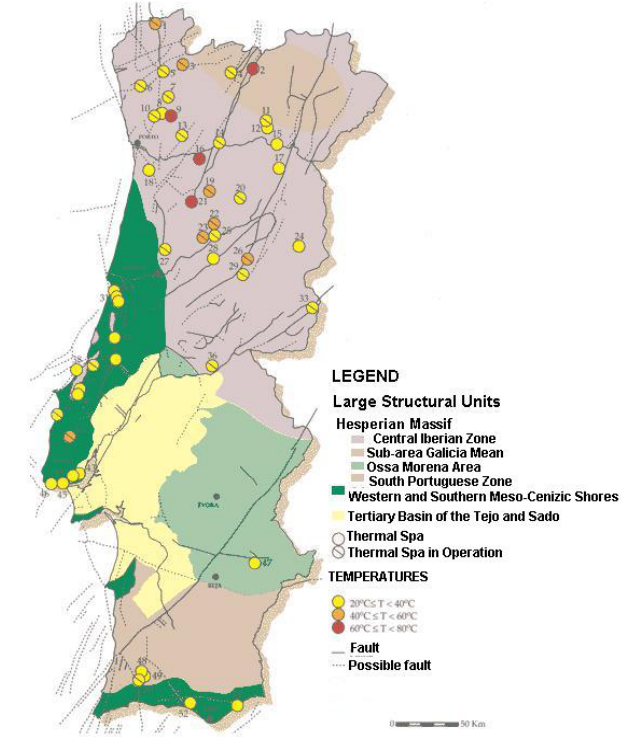
Figure 1. Thermal spas in